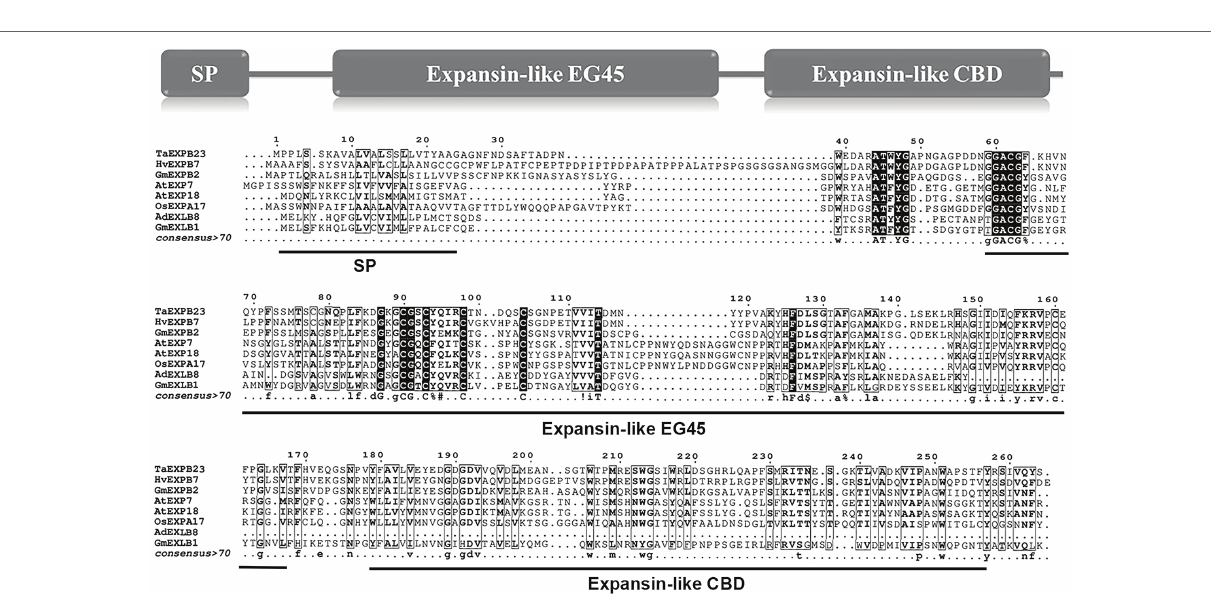
FIGURE 2 | Alignment of the amino acid sequences of GmEXLB1 and other expansins. Alignment of GmEXLB1 with TaEXPB23 (AAP84631.1), HvEXPB7 (ALP44111.1), GmEXPB2 (ACA83732.1), OsEXPA17 (XP_015642083.1), AtEXP7 (NP_172717.1), AtEXP18 (NP_176486.1), and AdEXLB8 (XP_015963649.1). Conserved sequence motifs are indicated by arrows. SP, signal peptide; Expansin-like EG45, expansin, family 45 endoglucanase-like domain; Expansin-like CBD, expansin, cellulose-binding-like